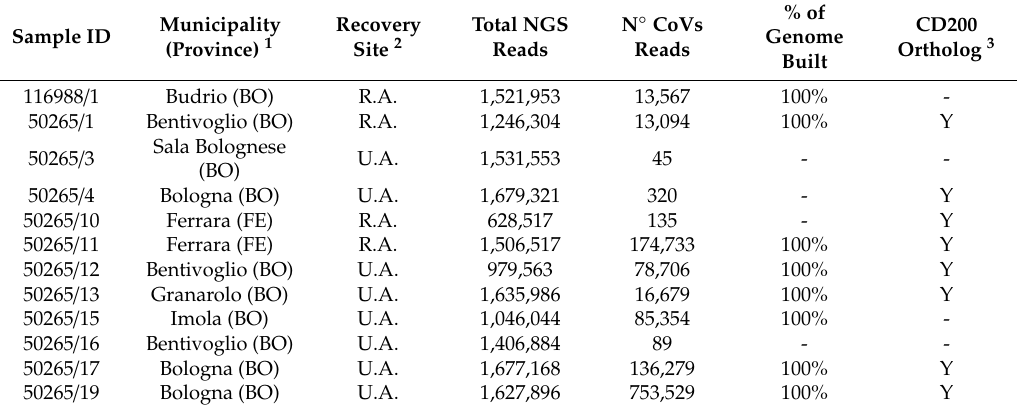
Table 1. Summary of NGS results and CD200 detection obtained by sequencing the 12 Erinaceus coronavirus (EriCoVs) from hedgehogs sampled between November 2018 and January 2019. Sites of collection are also